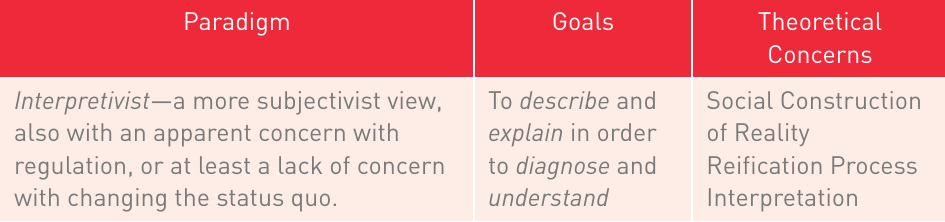
Theory Building under Four Paradigms (Reproduced from Gioia and Pitre (1990, p.591)) Paradigm Goals Theoretical